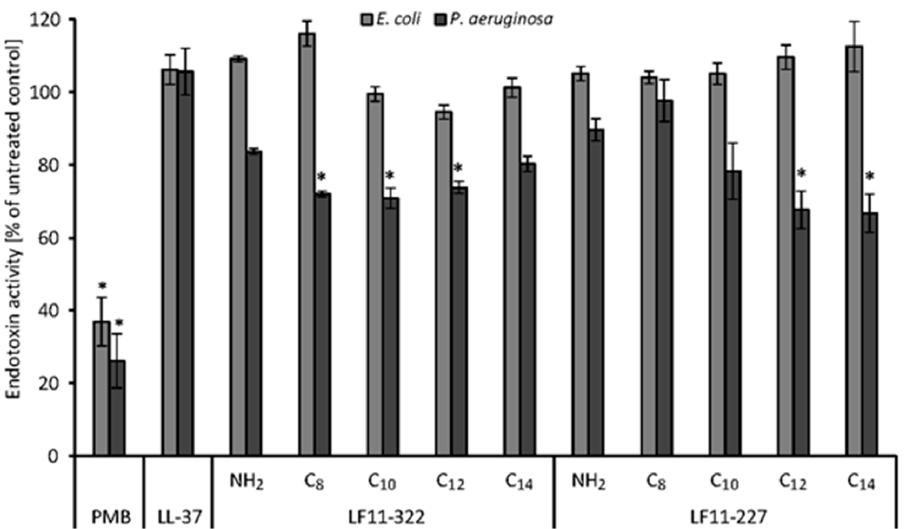
Figure 2. Endotoxin binding activity of 5 ng / mL endotoxin from E. coli and P. aeruginosa in human Serum. Serum with 5 ng / mL lipopolysaccharides (LPS) and without antimicrobial peptide (AMP) served as positive control and was set to 100%. The endotoxin activity of the peptide spiked serum was related to the positive control. The bars marked with * show a significantly ( p < 0.05) lower endotoxin activity than the positive control ( n = 3).